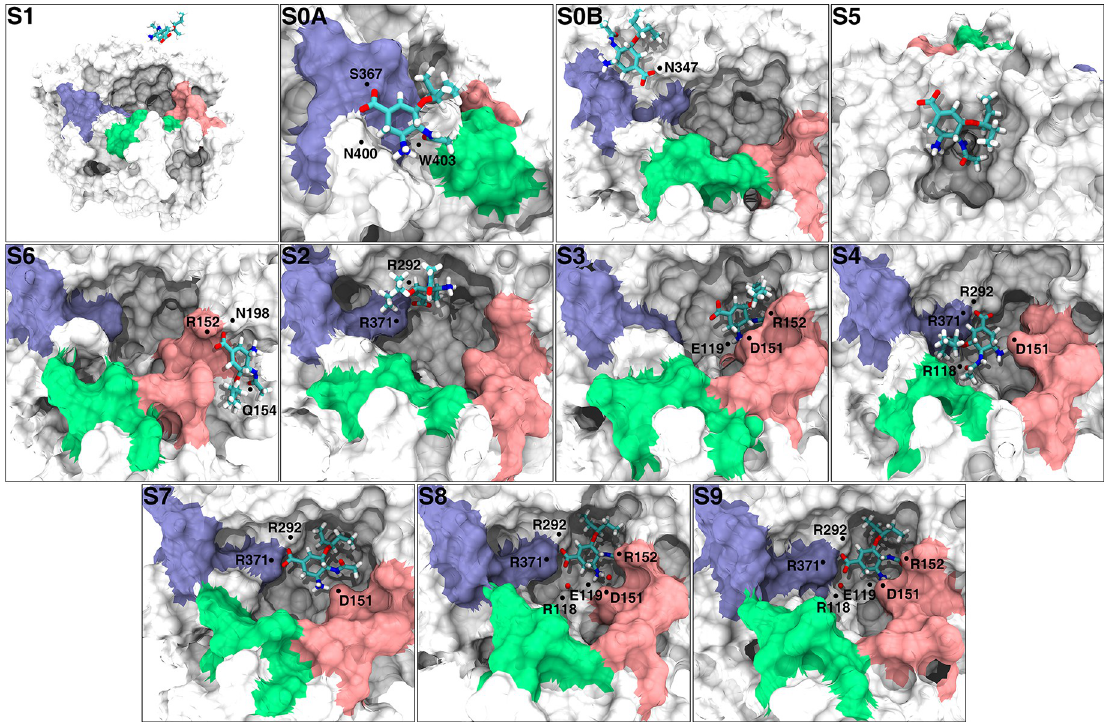
Fig 3. Interaction of oseltamivir with NA in metastable S0-S9. The position of the residue that participated in H-bond interactions with oseltamivir is marked with black dots. The red spheres in S8 and S9 represent the oxygen atoms of water molecules (the hydrogen atoms of water molecules are not shown), which participated in the formation of water-mediated H-bonds. The 150 loop, 370 loop and 430 loop regions are highlighted in pink, ice blue and green, respectively.